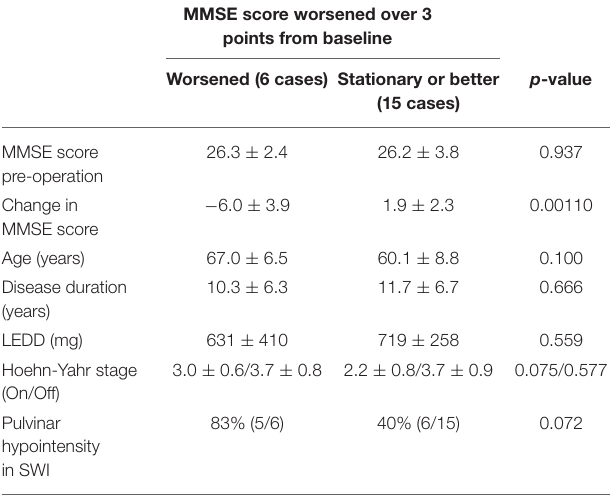
TABLE 3 | Comparison between the worsened and stationary or better MMSE score groups. MMSE score worsened over 3 points from